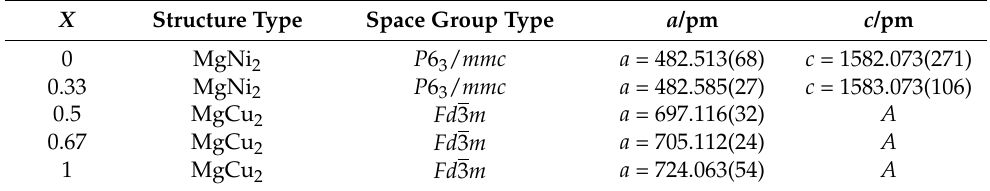
Table 1. Refined lattice parameters of Ca x Mg 1 − x Ni 2 compounds based on X-ray powder diffraction at 297(1)